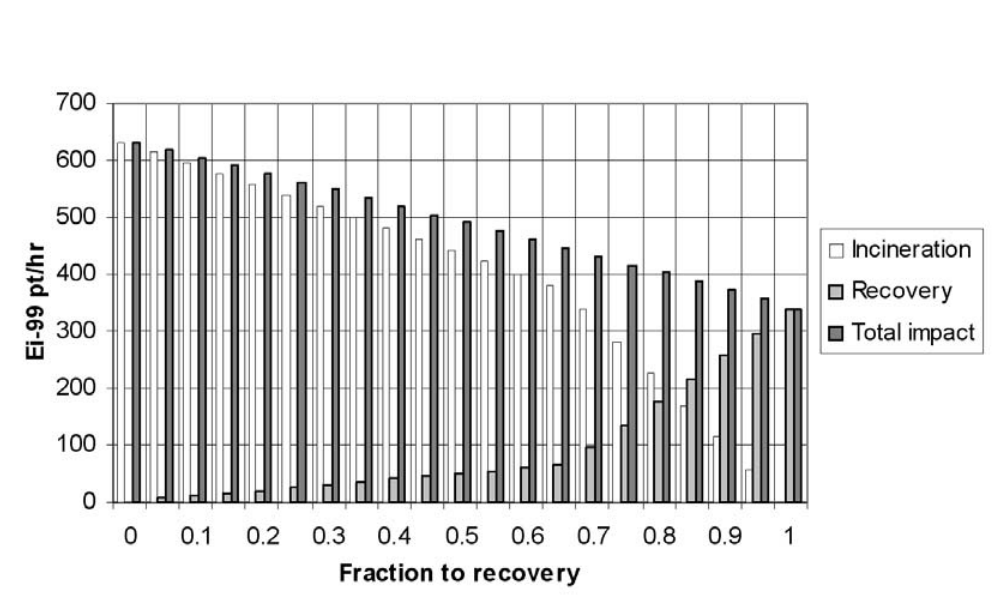
Fig. 6 Environmental impacts of the simultaneously working recovery applying EHAD scheme and incineration.